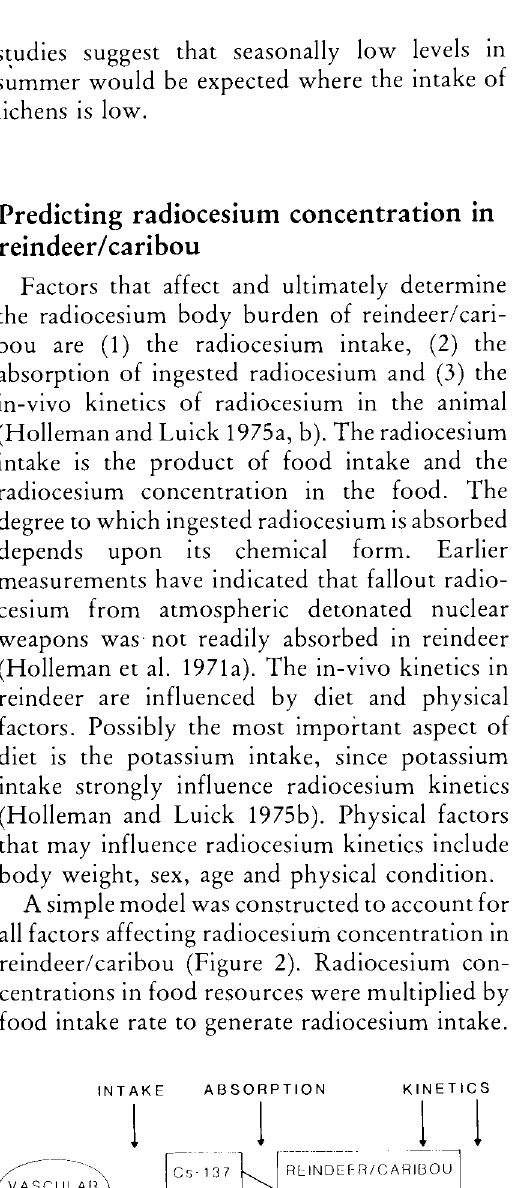
Figure 2. A model showing the movement of radiocesium from plants through reindeer/